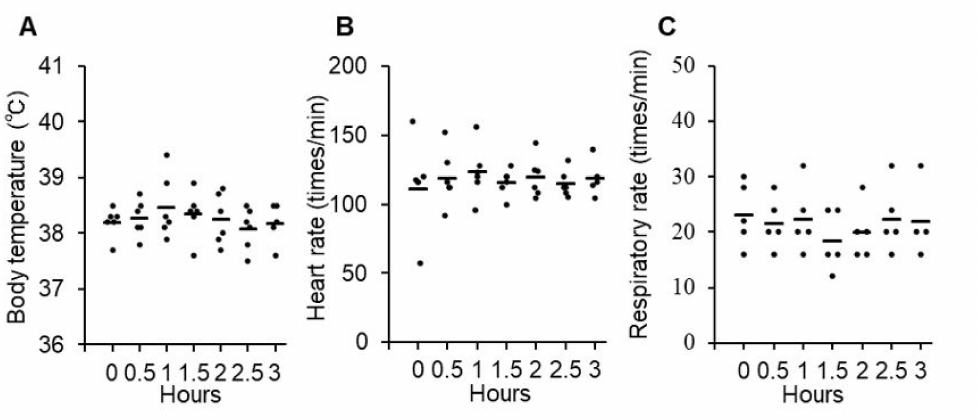
Figure 2. Evaluation of acute adverse e ff ects of P38Bf administration in three dogs. E ff ects of